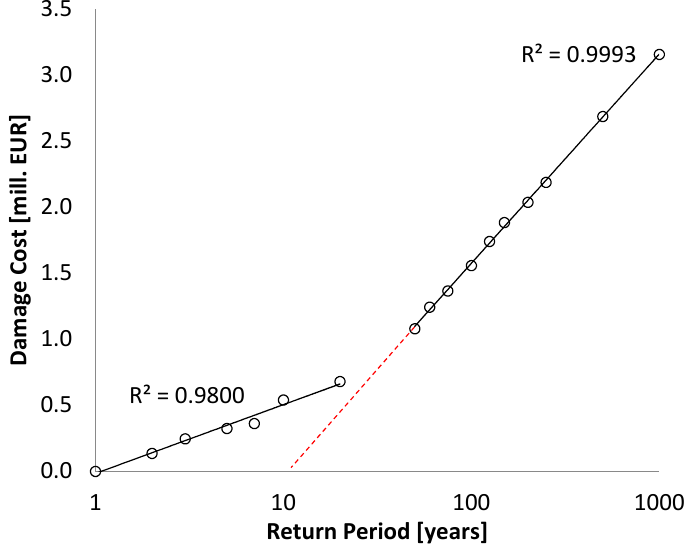
Figure 11. Accounting for the shift in the log-linear relation for the study area in Odense.